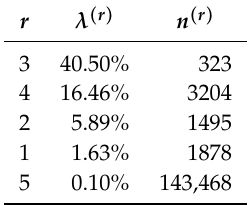
Table 6. Expectations of involving a lawyer in different